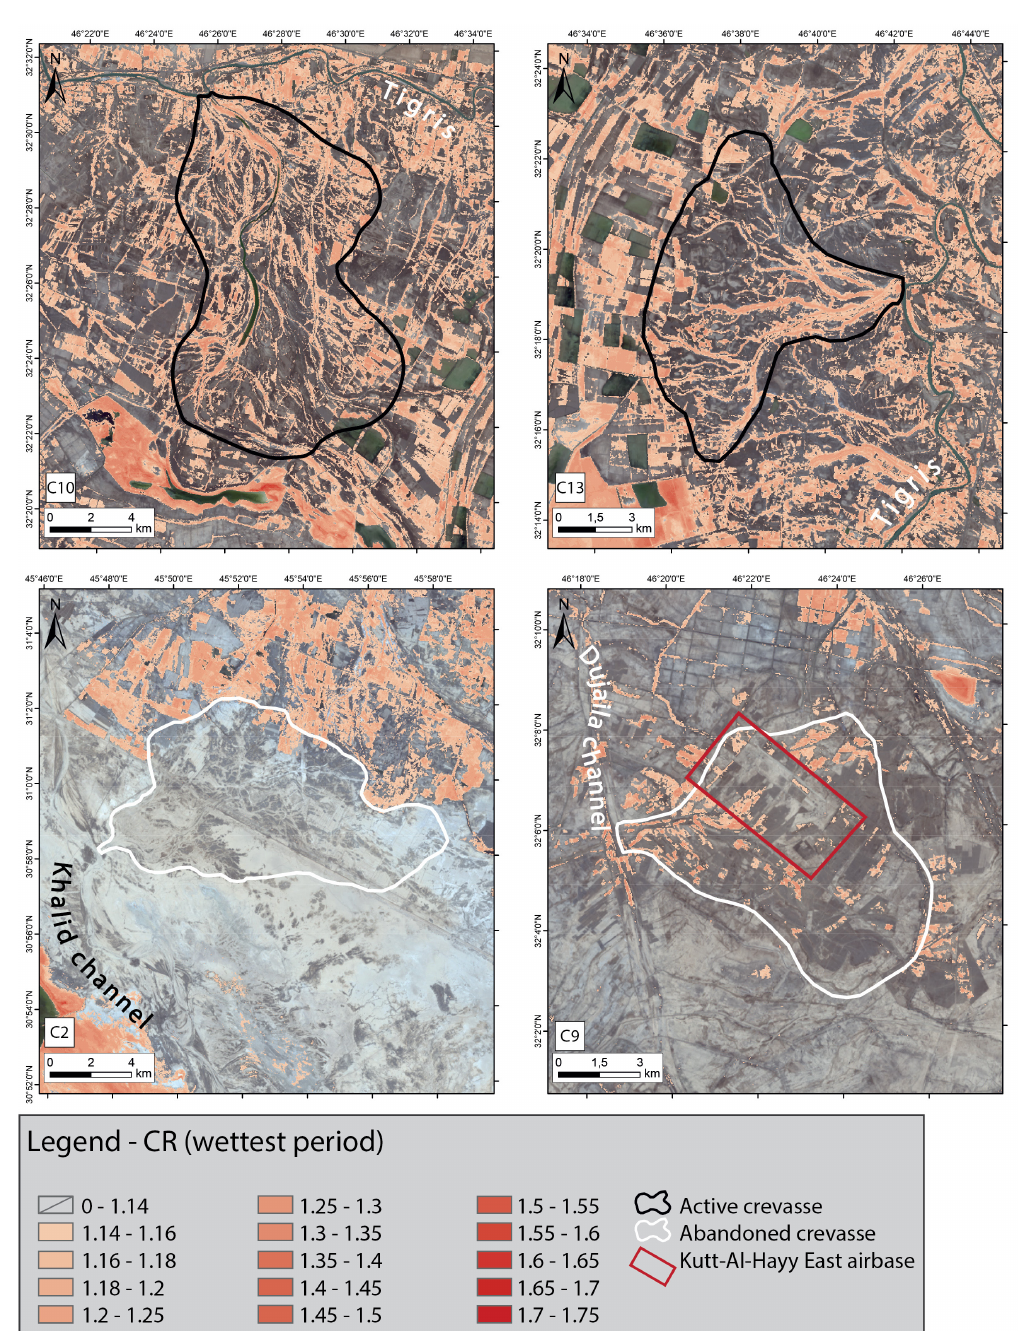
Figure 11. Spatial distribution of the CR, during the wettest period, for the active ( C10 , C13 ) and the abandoned ( C2 , C9 ) crevasse splays.